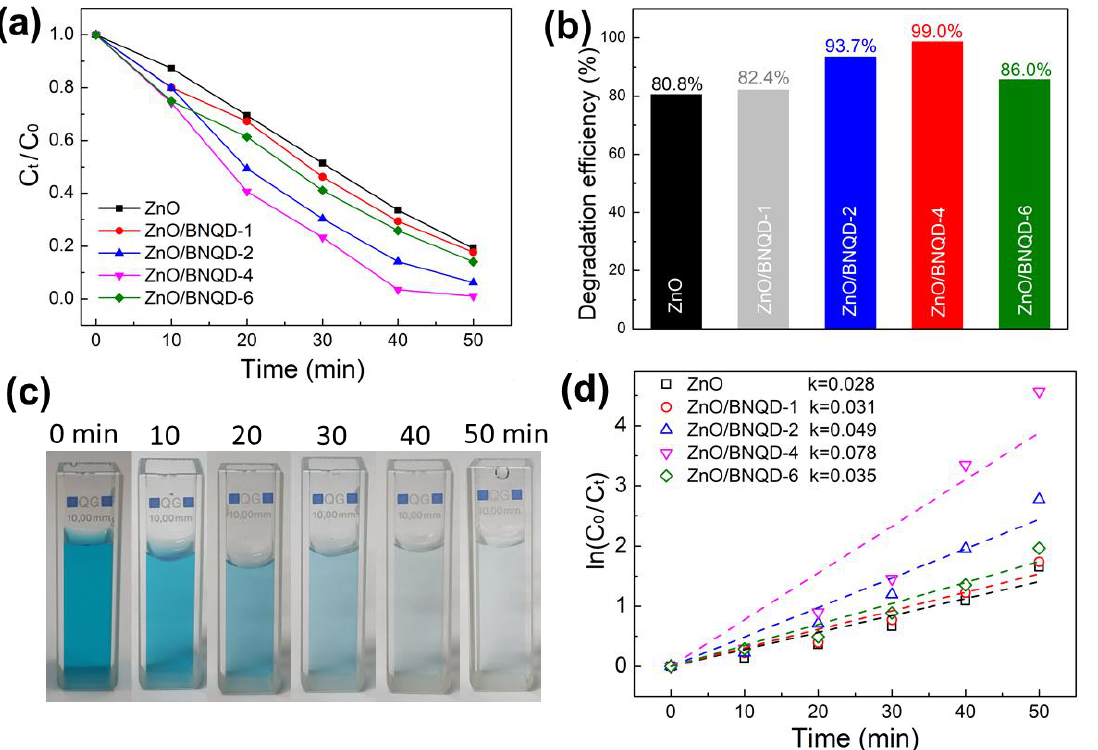
Figure 5. Photocatalytic degradation of MB; ( a ) plots of C t /C 0 vs. UV irradiation time, ( b ) degradation efficiency, ( c ) a photograph of the color change of MB for different irradiation times decomposed by ZnO/BNQD-4, and ( d ) plots of ln(C 0 /C t ) vs. irradiation time.